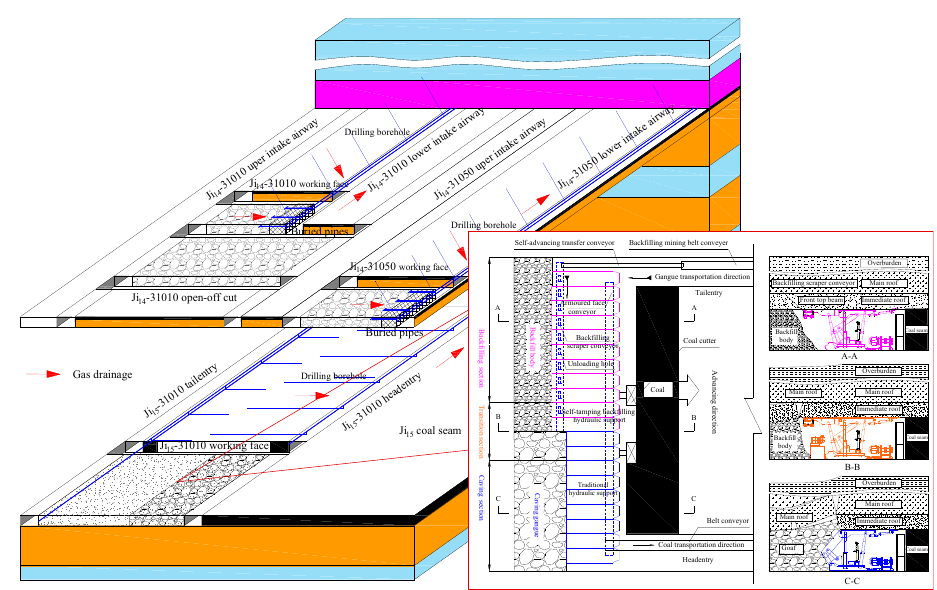
Figure 2. Layout of mixed mining longwall face.